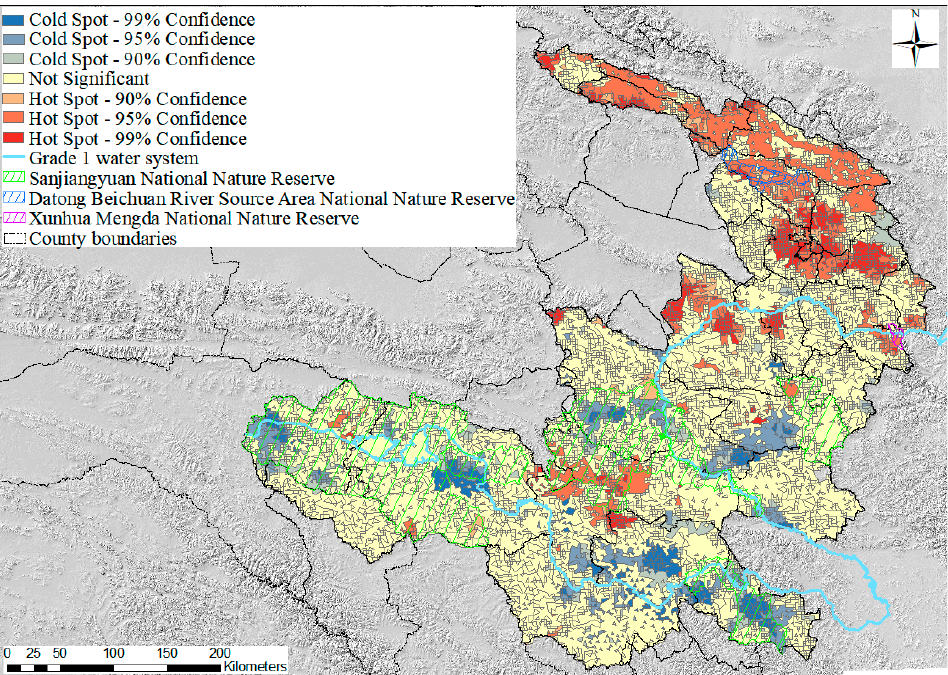
Figure 6. Distribution map of stressed hotspot areas of biodiversity conservation ecosystem service functions.